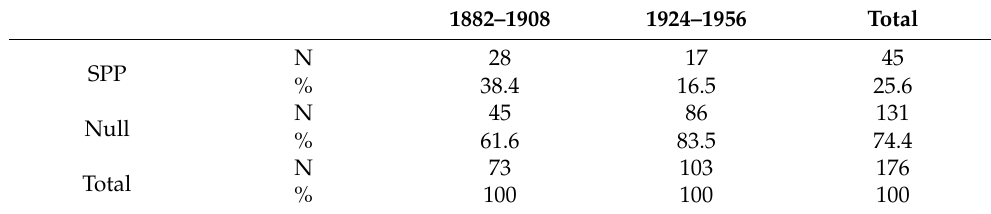
Table 9. Crosstabulation of first person singular verbs in same reference contexts across